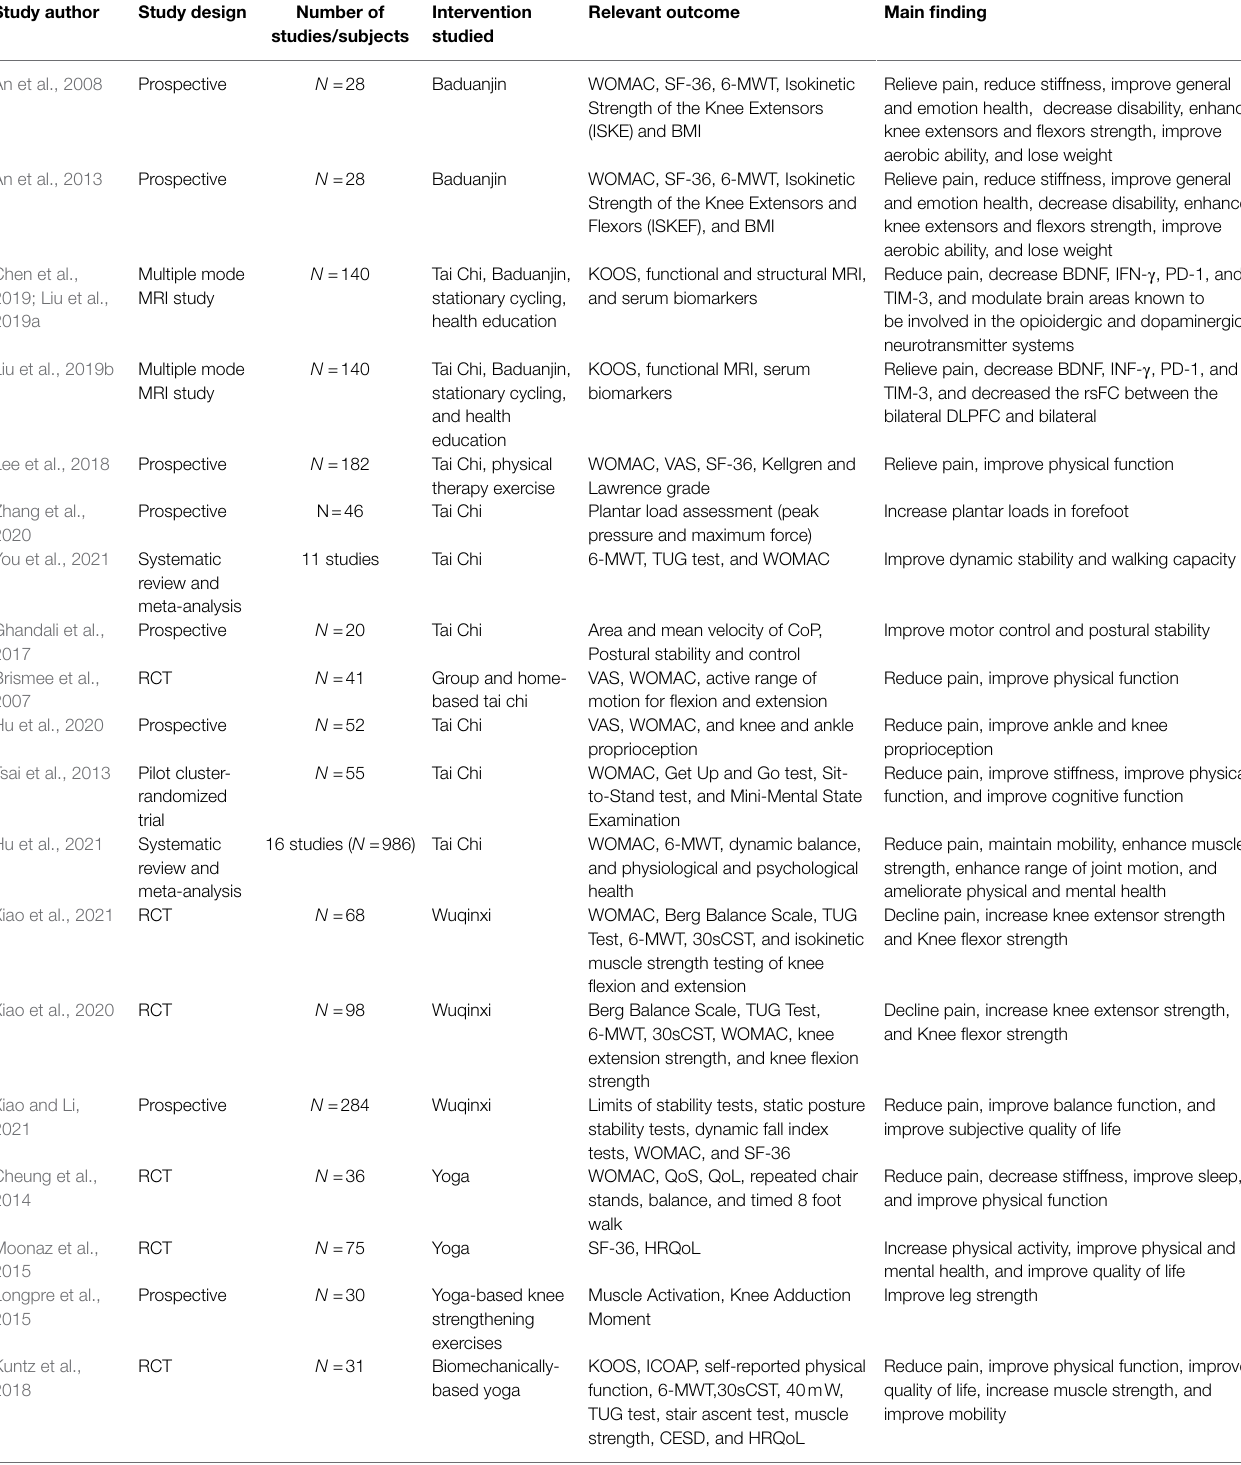
TABLE 2 | Summary of traditional exercise included in this